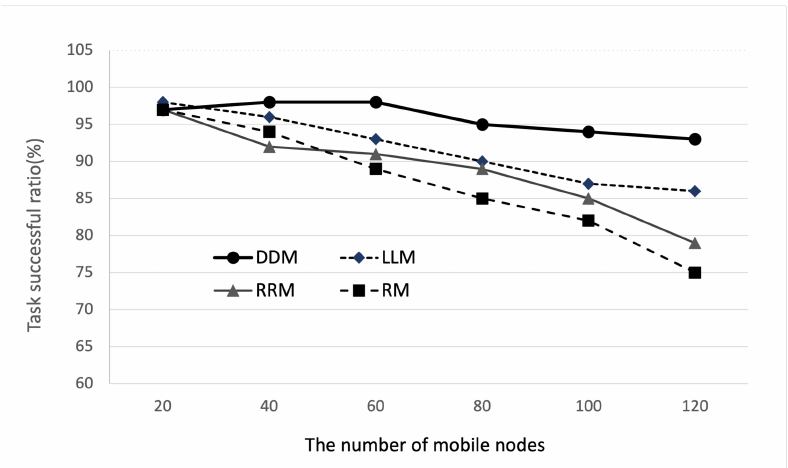
Figure 10. Task successful ratio according to the number of mobile